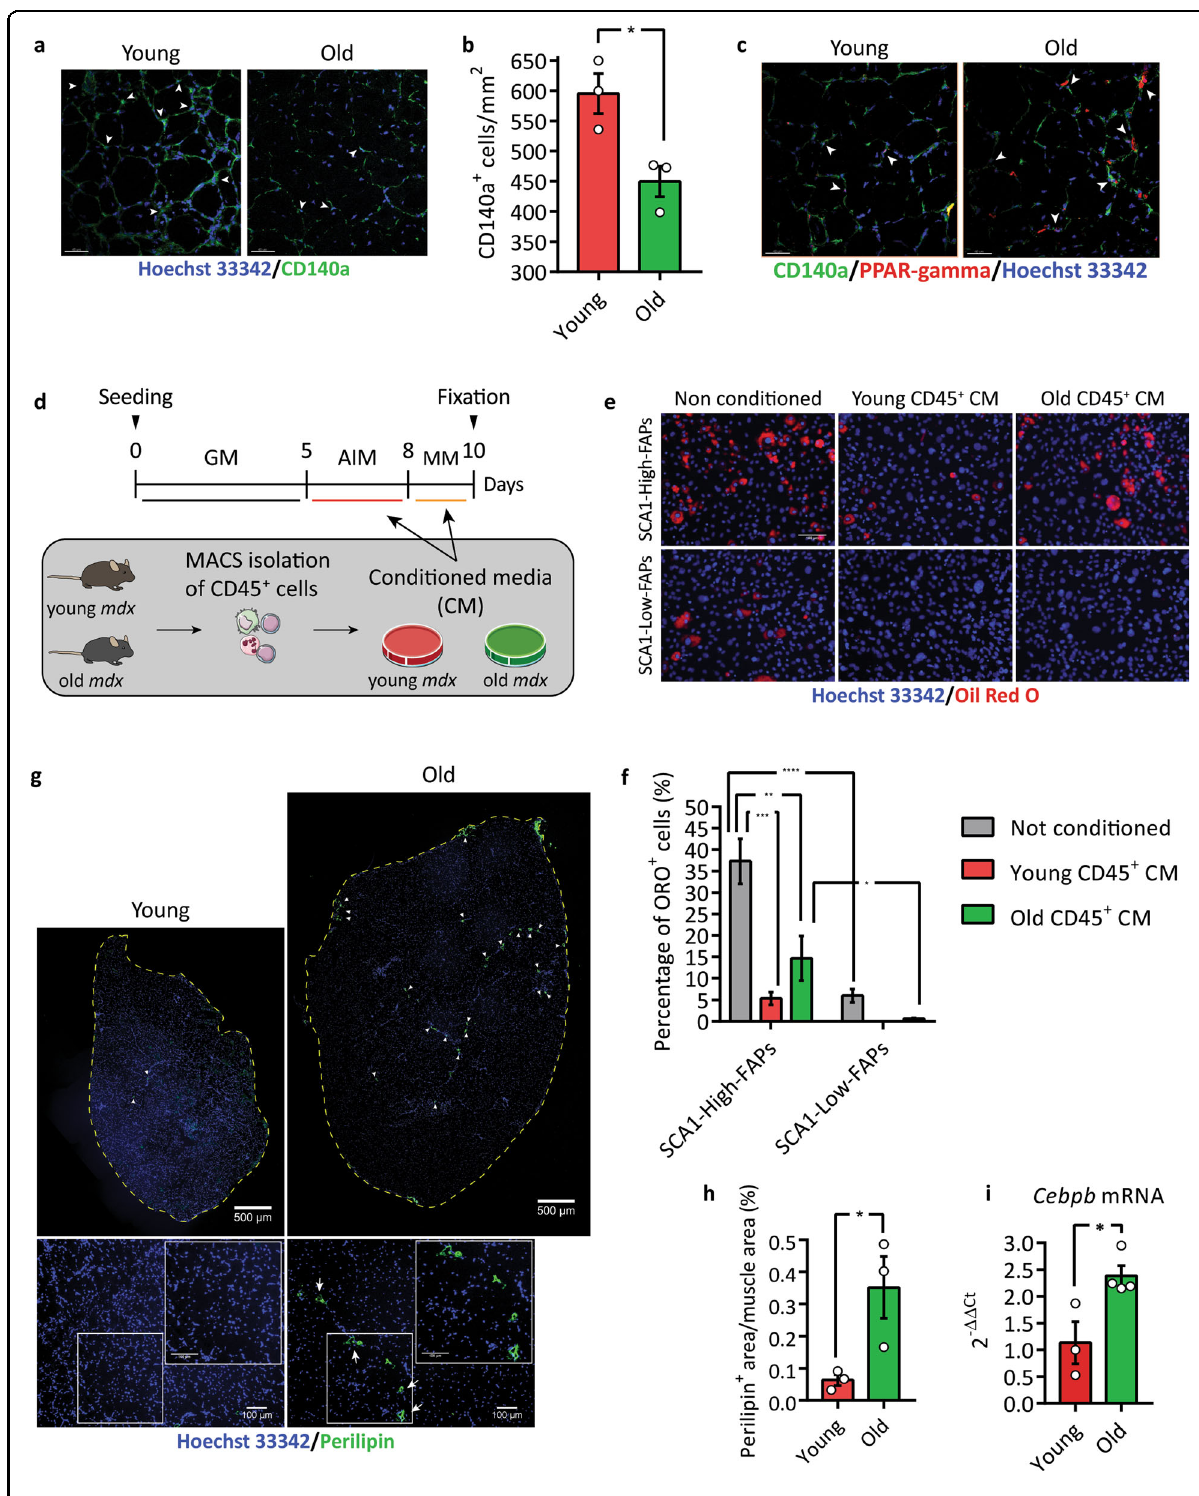
Fig. 8 (See legend on next